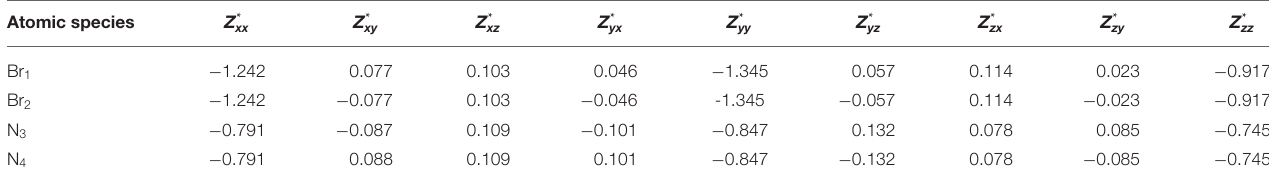
TABLE 4 | Born effective charge tensor for Br and N ions of α -DIPAB using Density Perturbation Functional Theory (DPFT). Atomic species